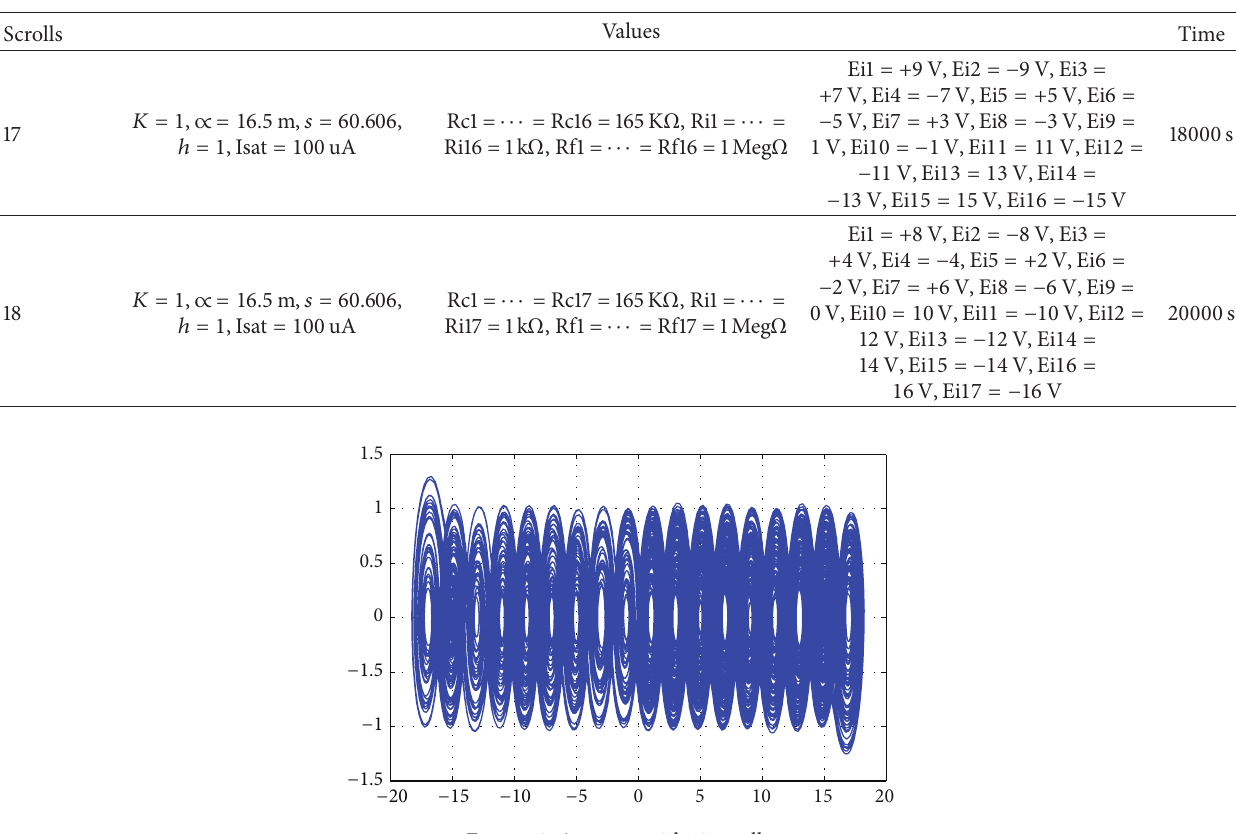
Figure 3: Attractor with 18